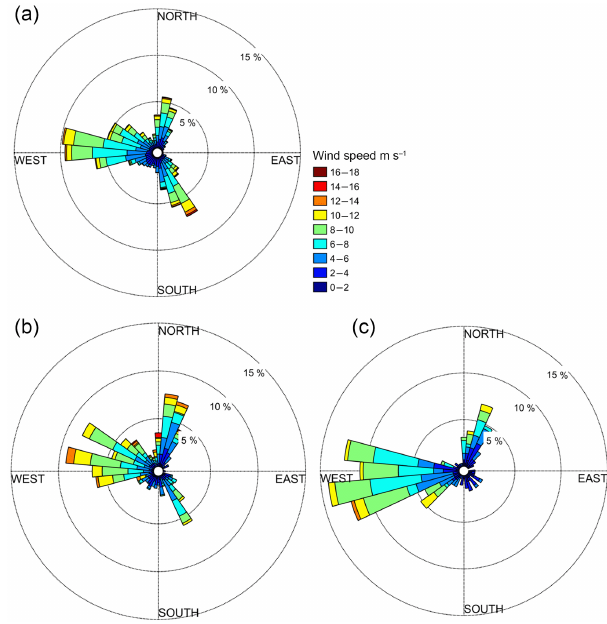
Figure 2. Wind roses at hourly intervals (a) at Hawera during the eight growing seasons (September–April) between 2004 and 2011, (b) Hawera between 14 August and 26 October 2012, and (c) Ka- puni between 14 August and 26 October 2012, all showing daylight hours only (08:00–18:00). Wind speed is in ms − 1 . Data at Kapuni were collected at 10min intervals and averaged to hourly intervals to match Hawera